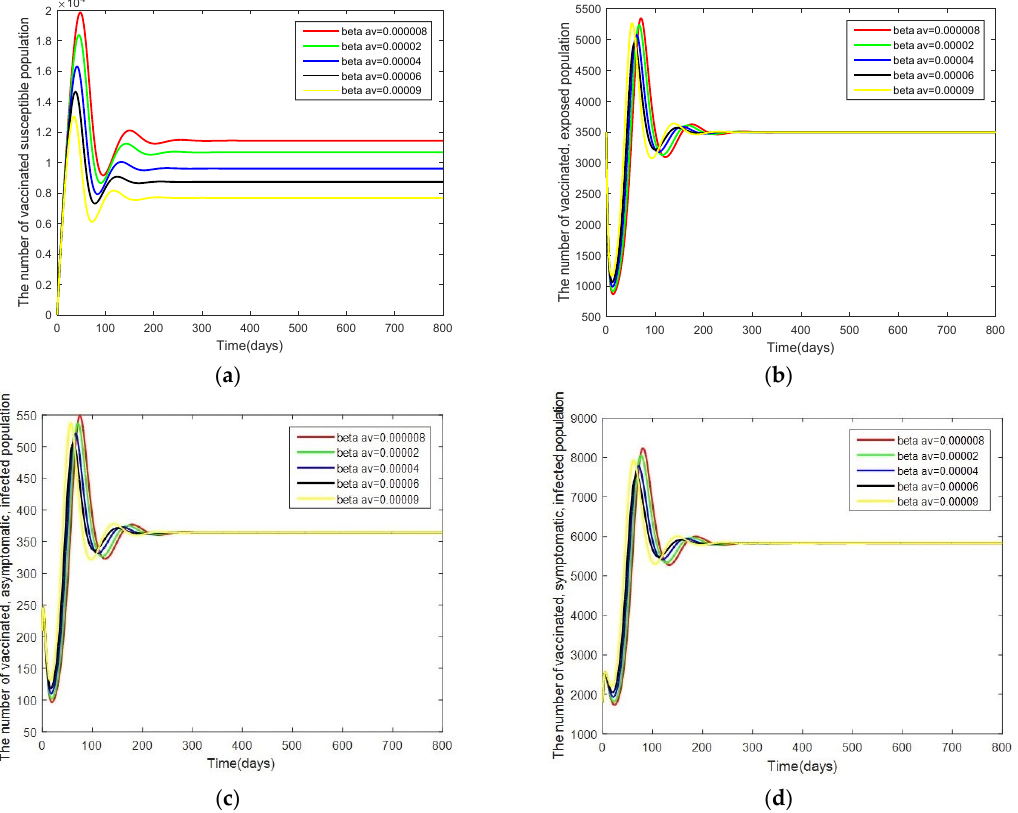
Figure 8. Graphs of the system of Equations (3)–(12) showing the comparison results of the infection rate of the asymptomatic, vaccinated, infected population ( β av ) when R 0 > 1: ( a ) the number in the vaccinated, susceptible population; ( b ) the number in the vaccinated, exposed population; ( c ) the number in the vaccinated, asymptomatic, infected population; and ( d ) the number in the vaccinated, symptomatic, infected population